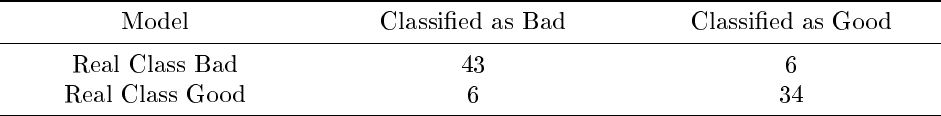
Table 5: Naive Bayes Results (tested in subset